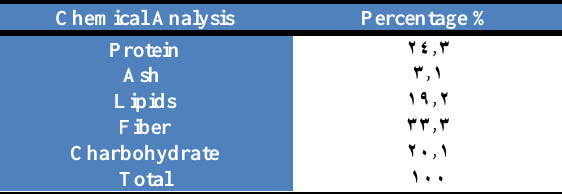
Table, 2: Chemical composition of the dried tomato seed meal